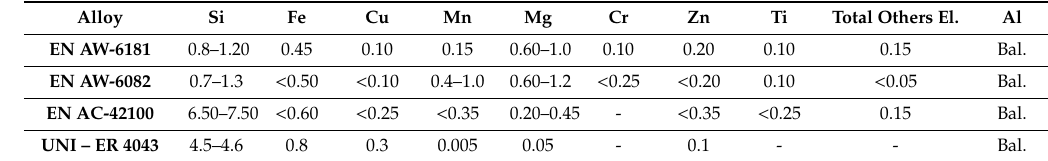
Table 1. Chemical composition of aluminum